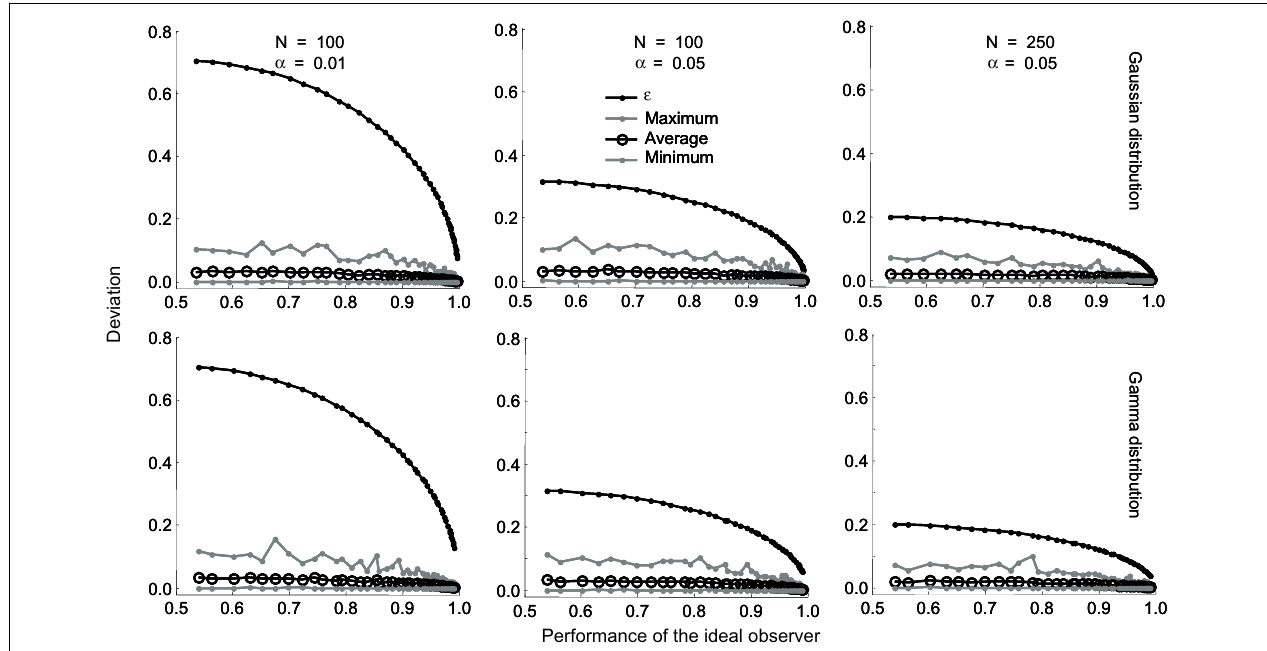
FIGURE 3 | Tightness of the bound in Equation (17). Results are shown for Gaussian ( top row ) and Gamma ( bottom row ) distributions. The difference between the mean values were progressively increased so that the true value of the ideal observer performance varied from 0.5 to 1.0. This performance is plotted on the X -axis. The performance was estimated 1000 times and the